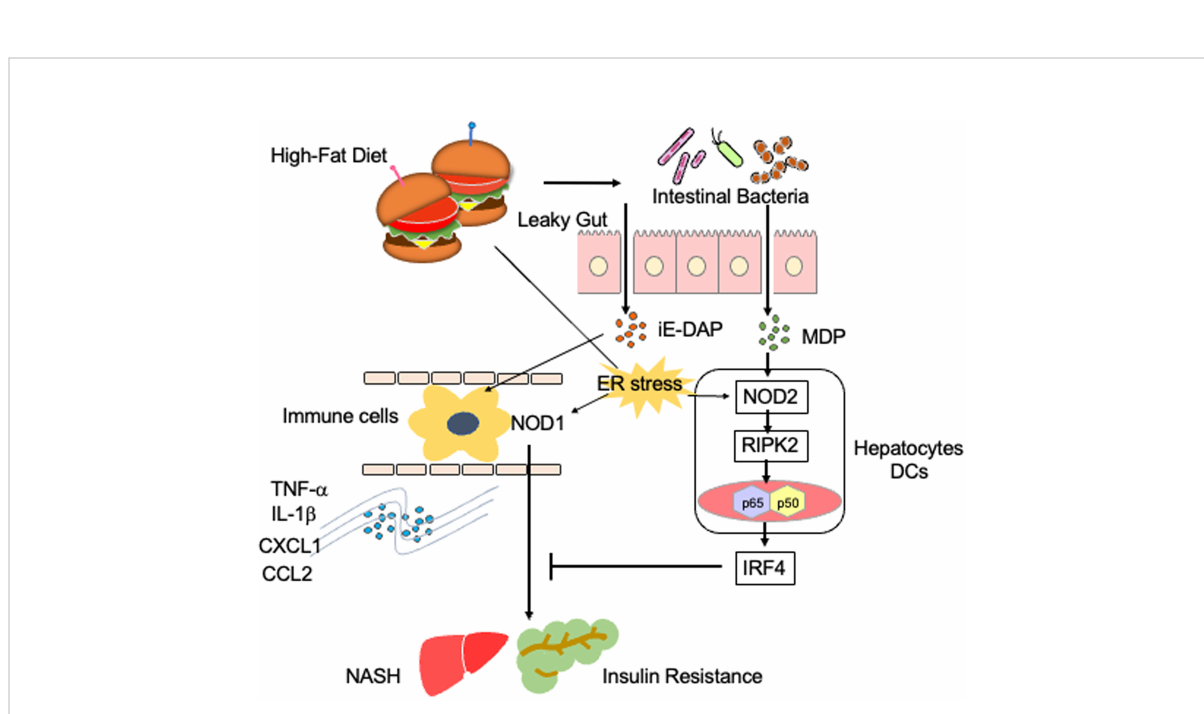
FIGURE 2 Proin fl ammatory roles played by NOD1 and NOD2 in steatosis. A high-fat diet causes gut leakage and activates NOD1 and NOD2 in gastrointestinal organs. g -D-glutamyl meso-diaminopimelic acid (iE-DAP) derived from intestinal bacteria activates NOD1 in circulating immune cells. NOD1 activation in circulating immune cells results in the development of NASH and insulin resistance via the production of IL-1 b and TNF- a . In contrast, muramyl dipeptide (MDP) derived from intestinal bacteria activates NOD2, which is expressed in hepatocytes or dendritic cells (DCs). The activation of NOD2 by MDP induces the expression of IFN regulatory factor 4 (IRF4) and thereby suppresses NOD1-mediated proin fl ammatory cytokine responses. Endoplasmic reticulum (ER) stress also activates NOD1 and NOD2.